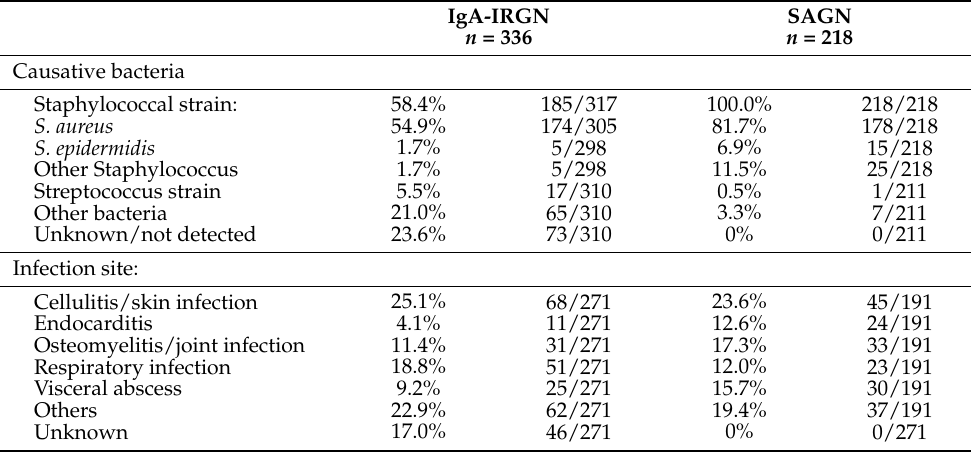
Table 2. Infectious features of the reported patients with IgA-IRGN or